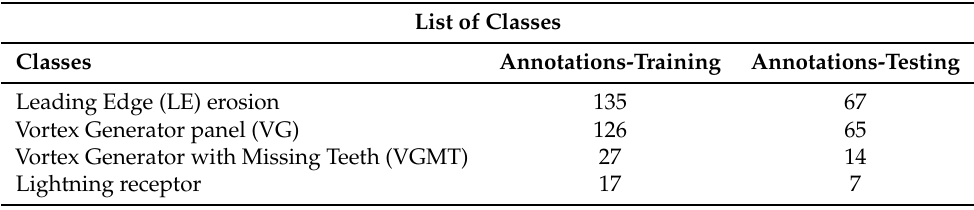
Table 1. List of classes in the training and testing sets related to the EasyInspect